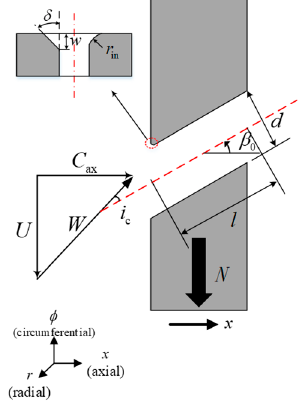
Figure 1. Geometry of rotating orifices.